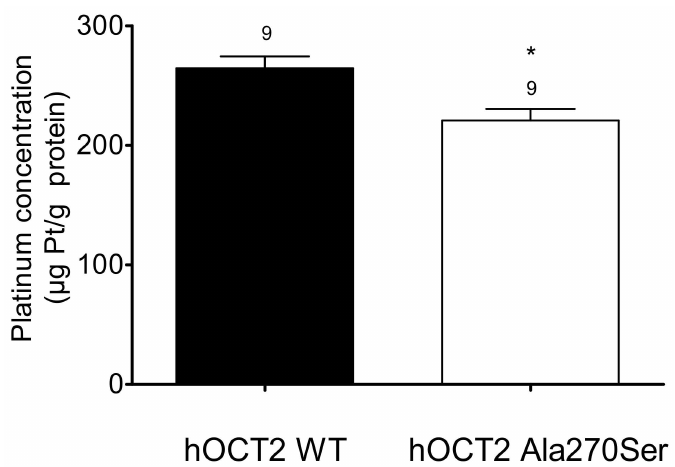
Figure 6. Cellular platinum concentrations ( µ g Pt / g protein, mean ± SEM) measured after 2 min incubation of hOCT2 WT ( (cid:4) ) and hOCT2 Ala270Ser ( (cid:3) ) cells with 100 µ M cisplatin. The number of replicates measured in three independent experiments is shown above the column. hOCT2 WT cells accumulated significantly more platinum than hOCT2 Ala270Ser cells (*, p < 0.05, unpaired